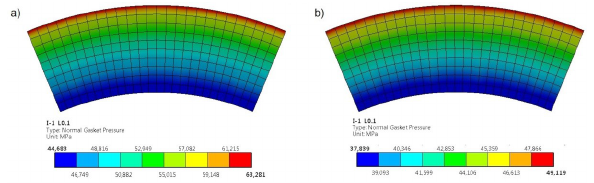
Figure 14: The radial contact stress along the gasket width in joint gasketed with FG_1 in all cases of loads